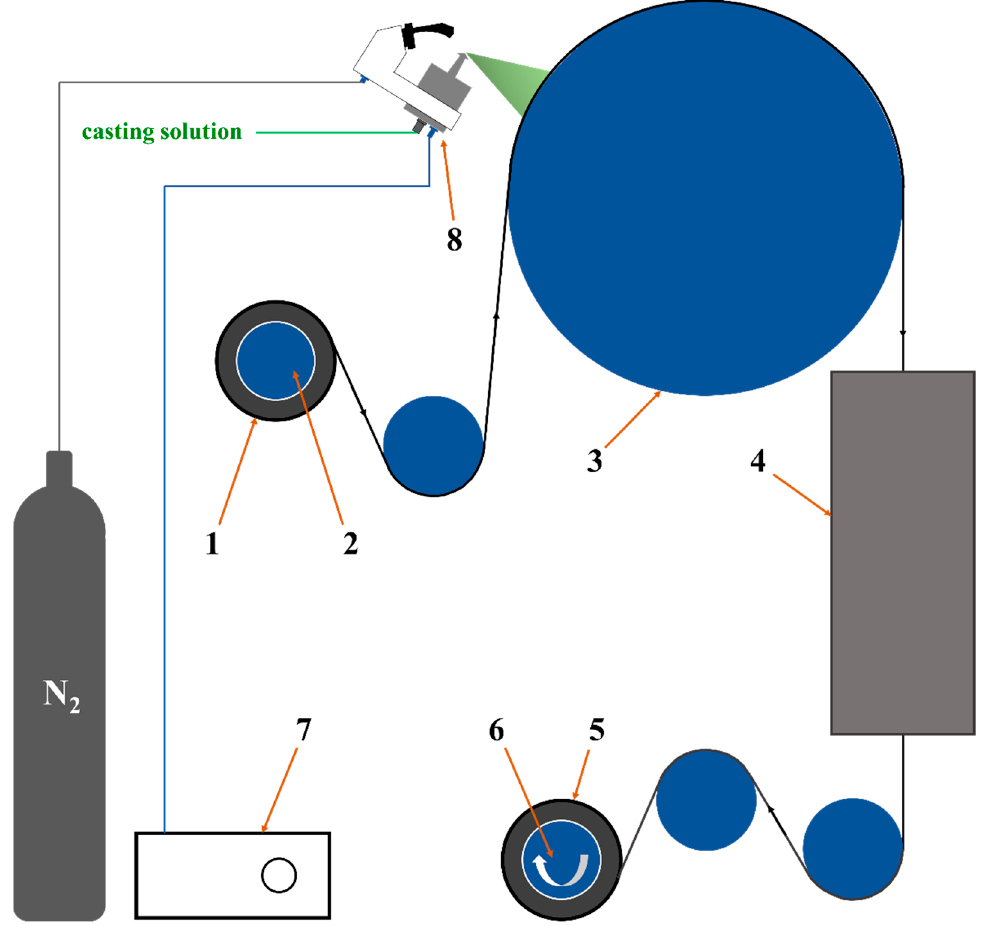
Figure 1. Schematic diagram of preparing the PVA composite membrane by homemade ultrasonic spraying equipment. 1. PTFE supports 2. Unwinding roller 3. Heating roller 4. Heating furnace 5. PVA composite membrane 6. Winding roller 7. Ultrasonic spraying controller 8. Nozzle.